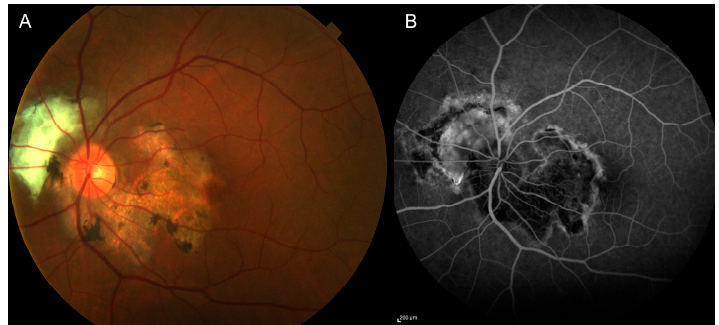
Figure 7. Serpiginous-like choroiditis, clinical presentation. Lesions are usually localized around the optic disc ( A ) and are characterized at FA by late hypo-fluorescence ( B ); an area of retinal atrophy is localized next to the optic disc ( A,B ).